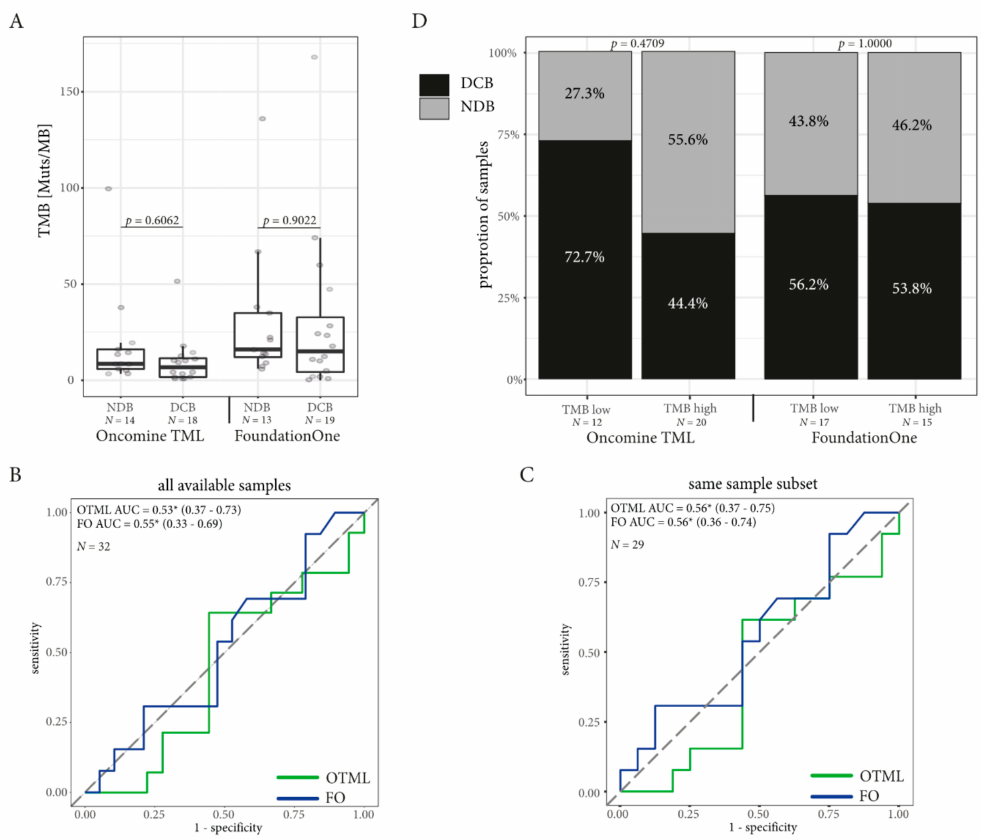
Figure 5. TMB as Biomarker in melanoma. The cut-o ff for high TMB population for the Oncomine TML panel (OTML) is set to 5.06 while the high TMB population in the FoundationOne test (FO) is defined by a TMB greater than 18 in the melanoma population. ( A ) There is no di ff erence in the mean TMB between the DCB and the NDB cohort in melanoma. ( B ) The ROC curves with their respective areas under the curve (AUC) are computed on all available data for each test individually. The 95% confidence interval is indicated in brackets. The asterisk indicates that the ROC curve favors the low TMB cohort and not the high TMB cohort. ( C ) The ROC curves with their AUC in the subpopulation where the TMB was correctly assessed using both tests in the same sample cohort allowing direct comparison of the di ff erent TMB panels. The 95% confidence interval is indicated in brackets. Again, the asterisk indicates that the low TMB cohort is favored in both panels. ( D ) There is no significant di ff erence in the ratio of DCB vs. NDB patients according to TMB independently of the panels used. The number of samples ( N ) used for calculation is mentioned on each figure.